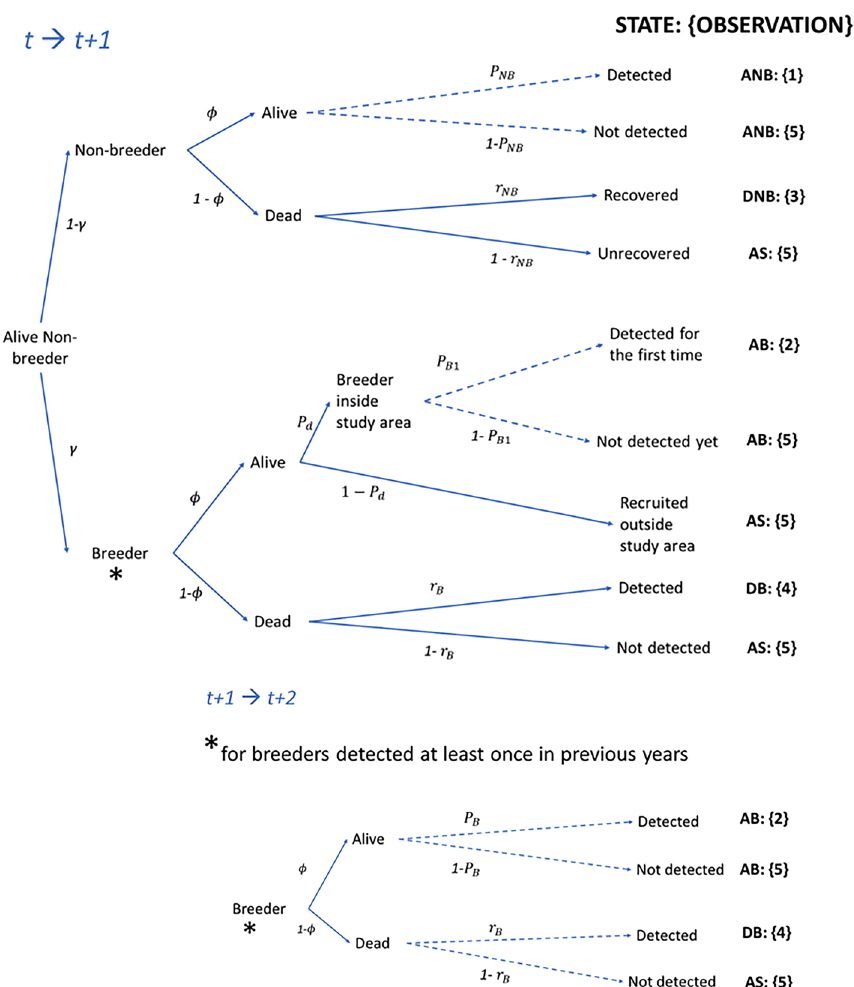
Figure 7. Graphical representation of state transitions, observations, and parameters from occasion t to t + 1 for an individual ringed at birth. Solid lines indicate transitions in the state matrix and dashed lines indicate transitions in the observation matrix. State codes are ANB (Alive Non-Breeder), AB (Alive Breeder ), DNB (Dead Non-Breeder), DB (Dead Breeder) and AS (Absorbing State). Numbers in brackets ({}) indicate corresponding codes in the observation matrix columns and encounter histories. Parameter symbols stand for survival (ϕ), recruitment (γ), recapture ( P B and P NB ), recovery ( r ) and the first-encounter breeder recapture parameter (P B1 ). *In the lower diagram, transitions of breeding individuals from t + 1 to t + 2 are shown. Because of the implementation of breeder recapture heterogeneity, individuals that become breeders at t + 1 may or may not be observed for the first time depending on probability P B1 . Once individuals are first observed, the observation probability P B is implemented at subsequent